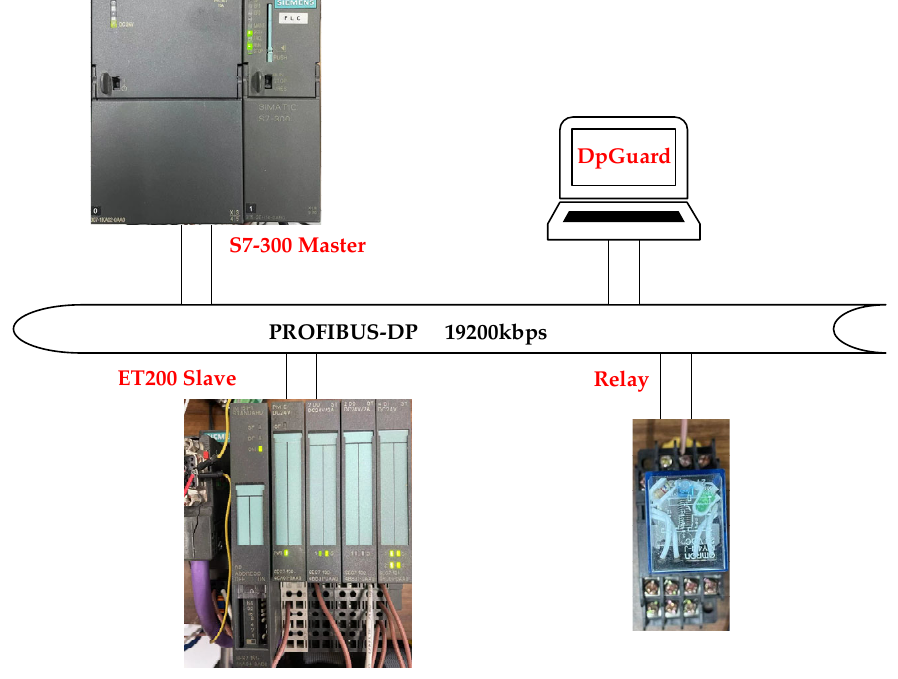
Figure 5. PROFIBUS-DP bus system. Figure 5. PROFIBUS‑DP bus